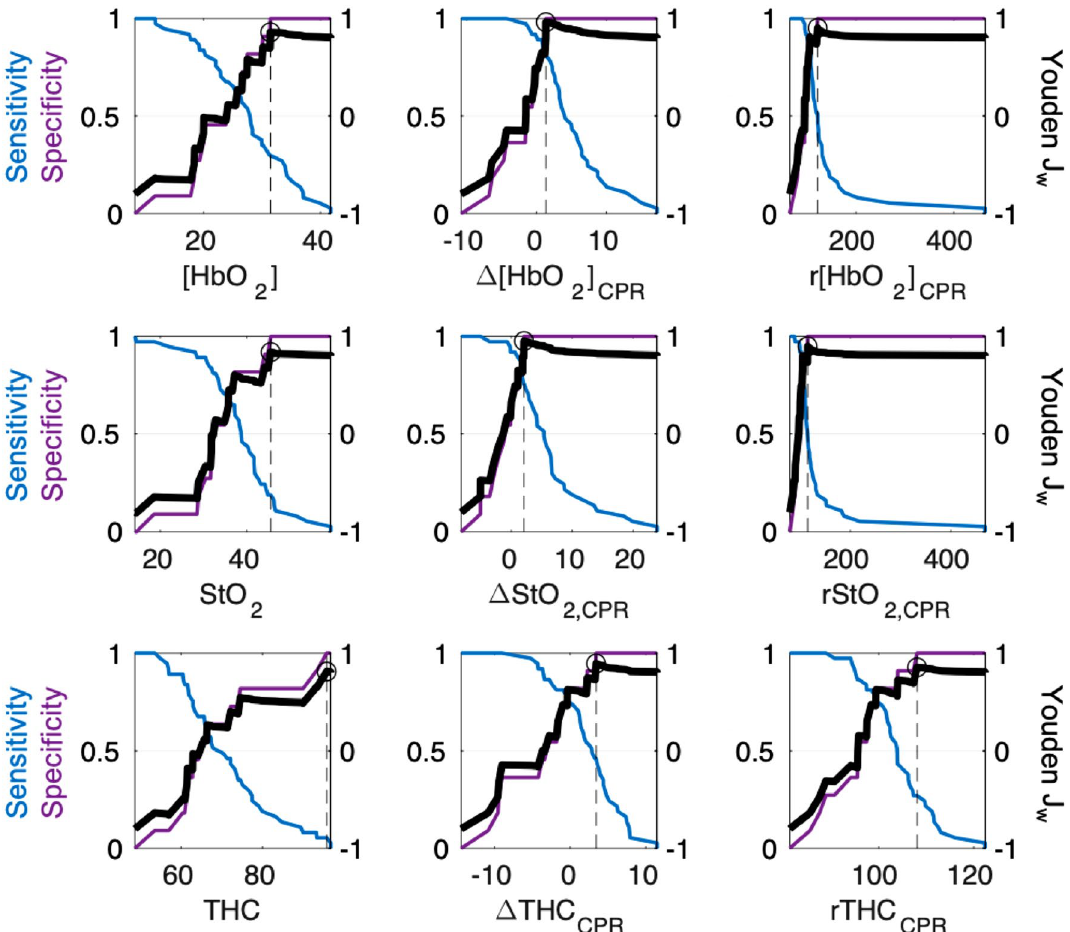
Figure 4. Selection of Optimal Predictor and Decision Threshold Based on Maximum Weighted Youden Index (J w ): From the mean value from 2 to 10 min of CPR, the optimal decision threshold was selected by maximum ROSC prediction performance, as assessed by the weighted Youden index (J w ). For each parameter, the sensitivity ( blue , left y-axis) and specificity ( purple , left y-axis) for ROSC, and the calculated Youden J w ( bold black line , right y-axis) are plotted for all possible threshold values (x-axis). The parameter-specific maximum J w is highlighted by a circle with a dotted line drawn to the corresponding threshold value on the x-axis; these values are listed in Table 3. Δ[HbO 2 ] CPR achieved the highest J w (0.96) overall; this corresponds to a decision threshold of + 1.3 µmol/L.